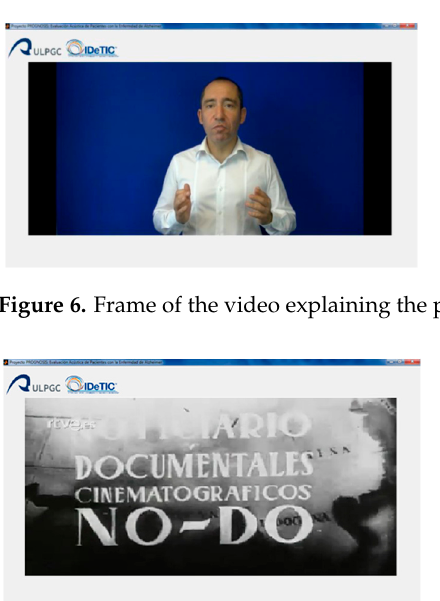
Figure 6. Frame of the video explaining the process. Instructions.